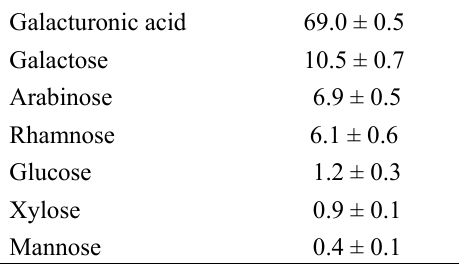
Table 1. Sugar composition (%) of Cicer arietinum L. pectin.